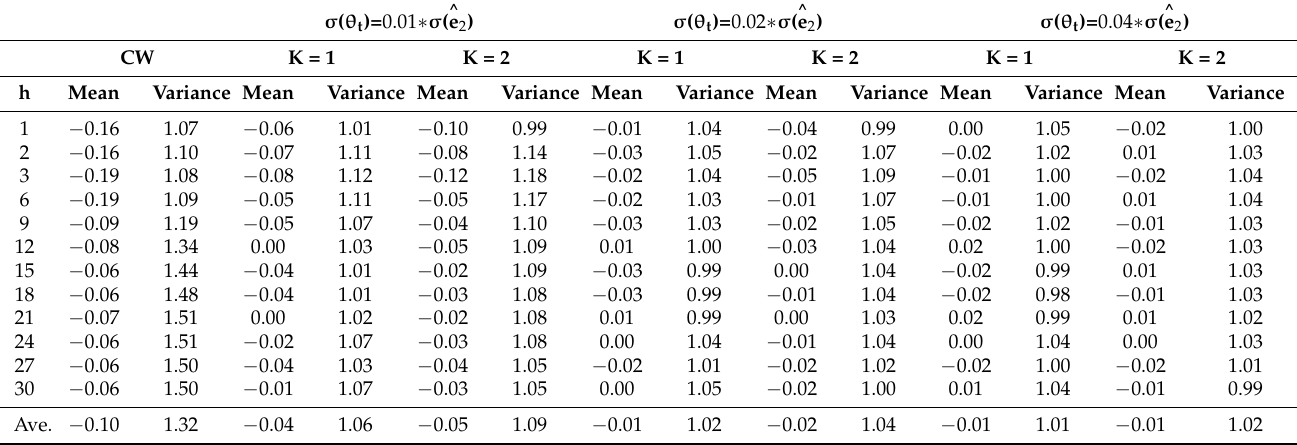
Table 13. Means and variances of the CW and WCW statistics for DGP2 under the null